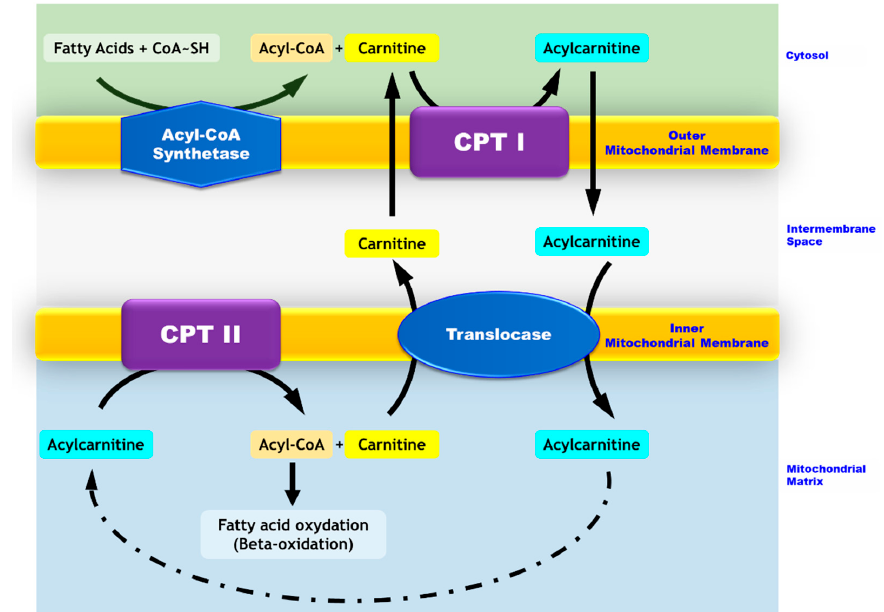
Figure 1. Mitochondrial transport of long-chain fatty acids. While medium- and short-chain fatty acids enter the mitochondria freely, long-chain fatty acids require carnitine-dependent transport to cross the mitochondrial membranes. In the cytosol, long chain fatty acids are converted to acyl-CoA by the acyl-CoA synthase. The carnitine palmitoyltransferase I (CPT I) located in the outer mitochondrial membrane catalyzes the conversion of acyl-CoA into acylcarnitines. The latter crosses the outer membrane and goes through the inner membrane via a transporter named translocase. Carnitine palmitoyltransferase II (CPT II), which is located in the inner mitochondrial membrane, allows for the conversion of acylcarnitines into acyl-CoAs and free carnitine. Carnitine exits the mitochondria